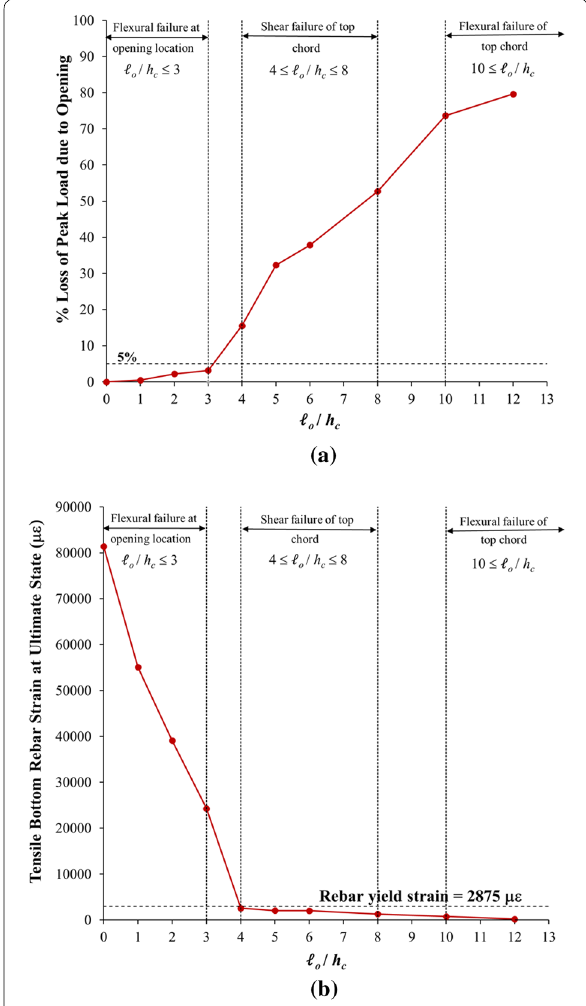
Fig. 19 Effect of opening size on performance of unstrengthened beams loaded at mid‑span (based on FE analysis): a with respect to peak load and b with respect to strain in bottom steel rebars at